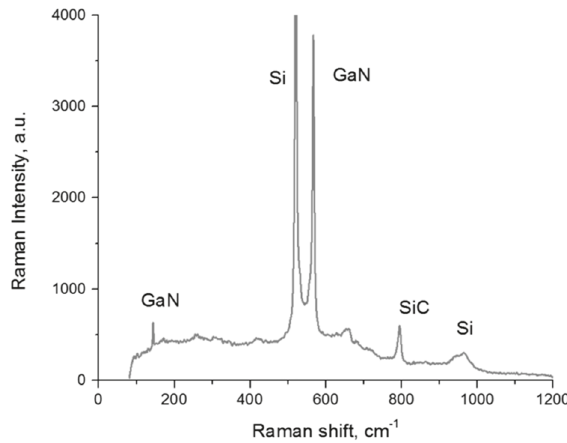
Figure 5: Typical Raman spectrum of GaN NWs grown on SiC/Si hybrid